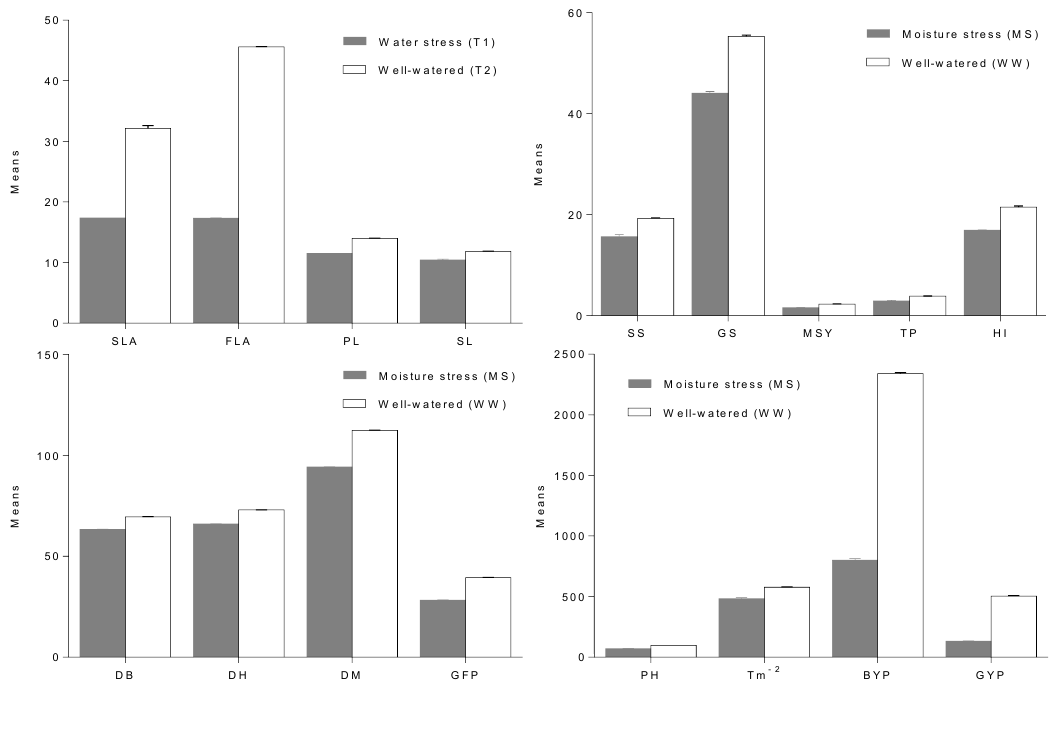
Figure 2 Mean performance of the wheat genotypes for yield and its associated traits, including second leaf area (SLA), flag leaf area (FLA), peduncle length (PL), spike length (SL), spikelets per spike (SS), grains per spike (GS), main spike yield (MSY), tillers per plant (TP), harvest index (HI), days to booting (DB), days to heading (DH), days to maturity (DM), grain filling period (GFP), plant height (PH), tillers per square meter (Tm 2 ), and grain yield per plot (GYP) in moisture stress (MS) and well-watered (WW) conditions.